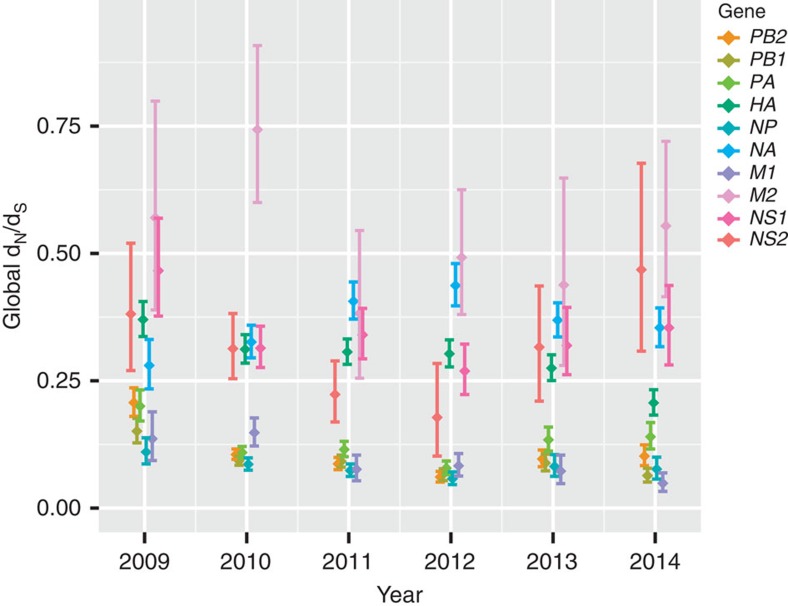
Selection pressures on human H1N1/2009 viruses over time.Yearly estimates of global dN/dS ratios for each gene using SLAC method, with the significance level at P<0.05. Each gene data set per epidemic year consisted of up to 500 randomly selected global sequences. The means of dN/dS ratios are indicated by diamond-shaped symbols with error bars representing 95% confidence intervals. Coloured bars correspond to different genes in the following order: polymerase basic 2 (PB2), polymerase basic 1 (PB1), polymerase acidic (PA), haemagglutinin (HA), nucleoprotein (NP), neuraminidase (NA), two matrix proteins (M1 and M2), and two non-structural proteins (NS1 and NS2).